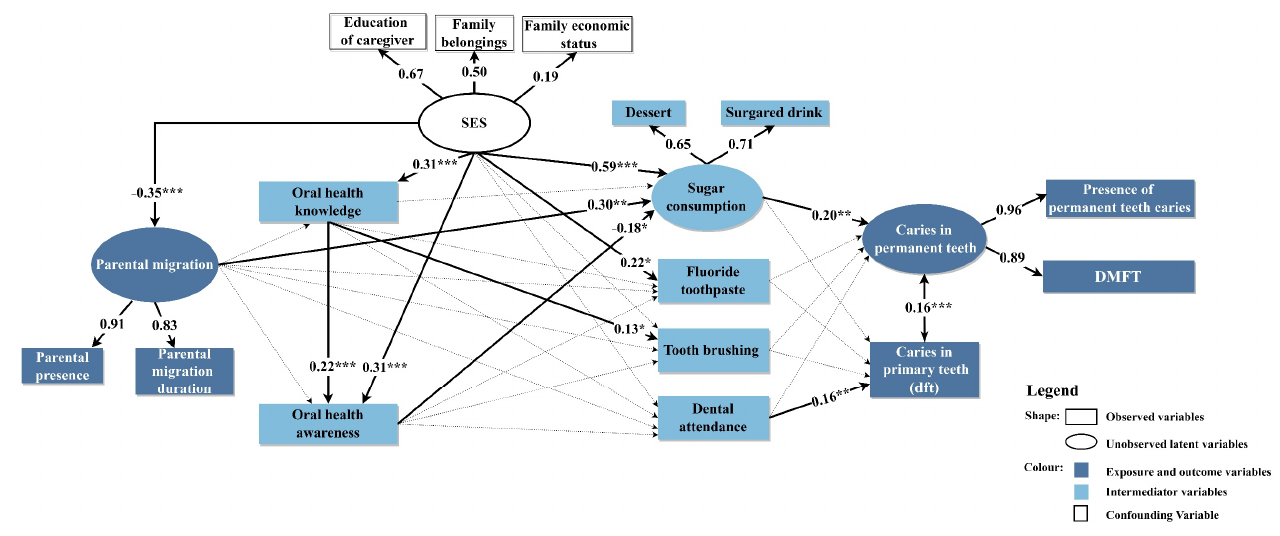
Figure 1. Structural equation model of the relationship between parental migration and dental caries in children. Note: The solid lines indicate significant relationships with the number on each line showing standardized path coefficients; the significant level for path coefficients was set at * p < 0.05, ** p < 0.01 and *** p < 0.001; The dotted lines indicate insignificant relationships.